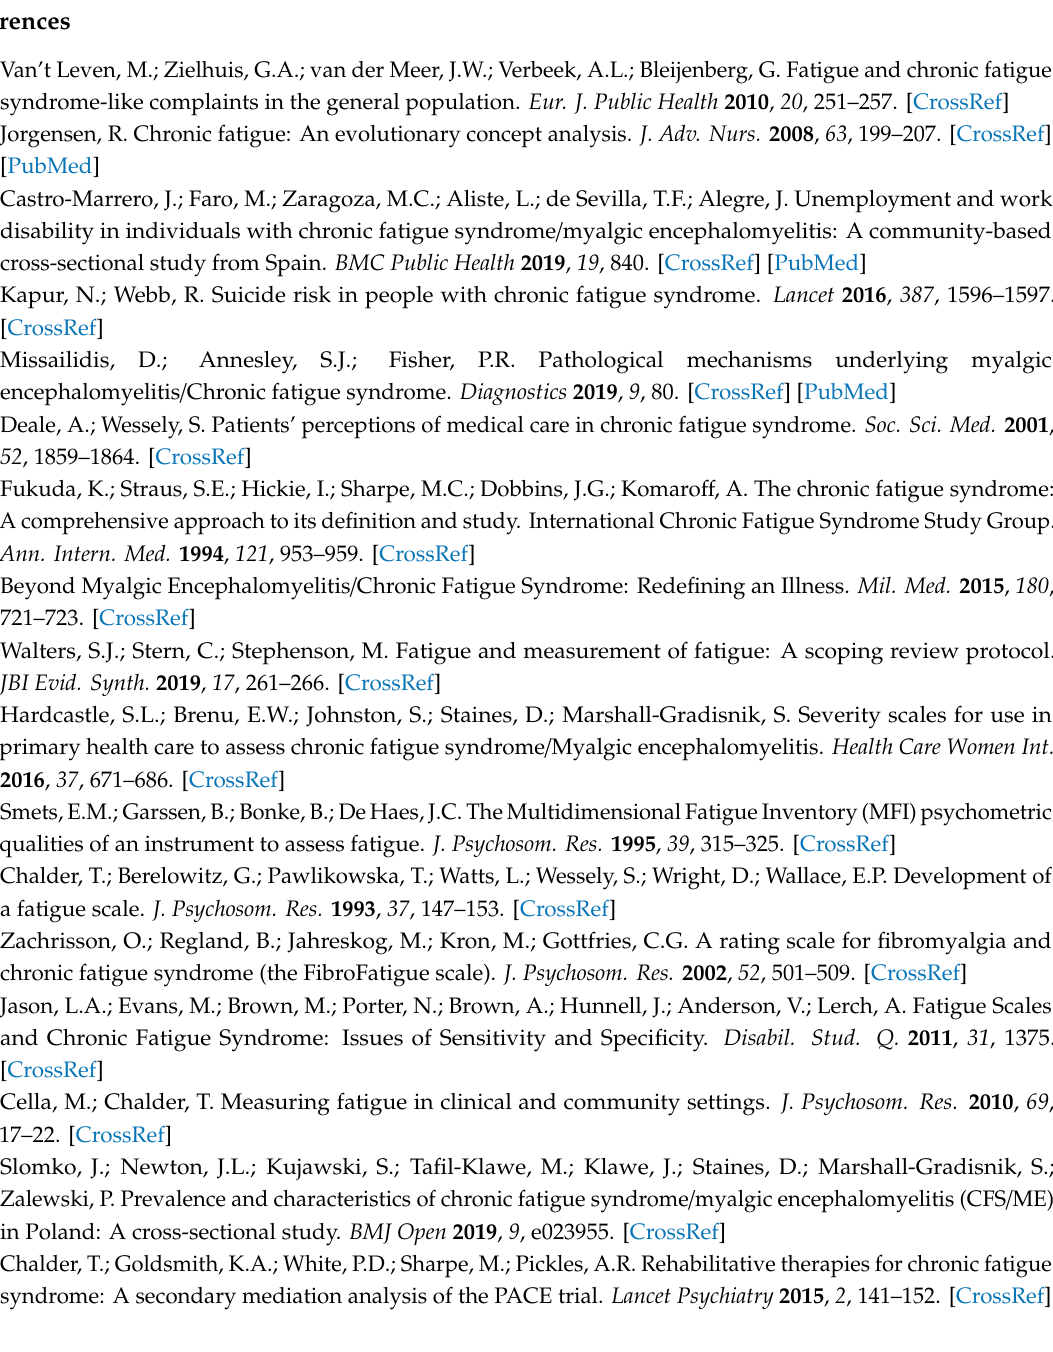
Table S1. Correlation between the mKCFQ11 biological